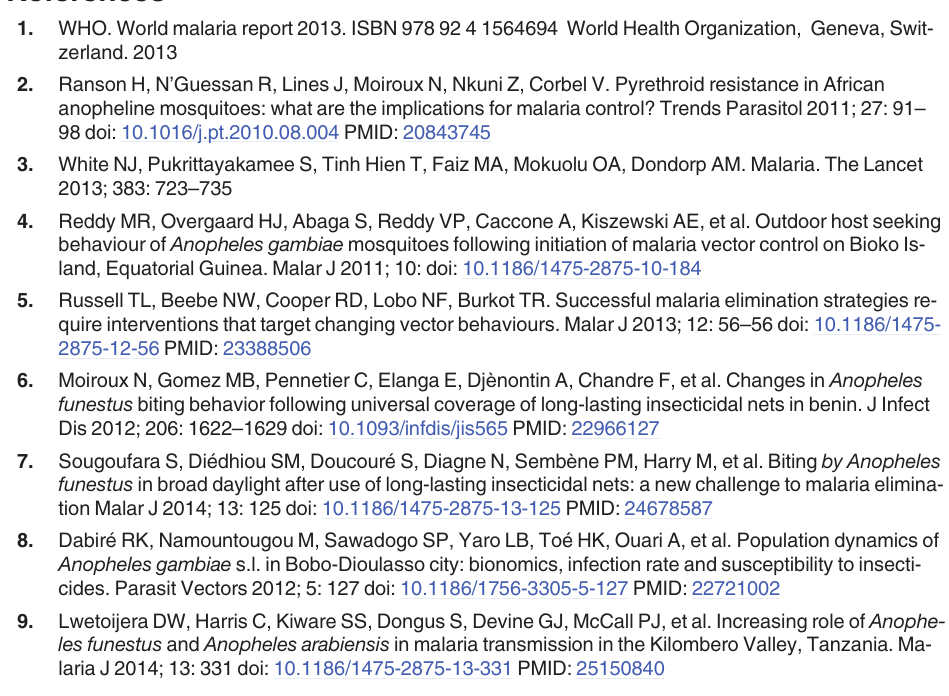
S2 Fig. Model simulations of a scenario in which mosquitoes are highly resistant against in- secticides. Shown is the entomological inoculation rate (EIR) as a function of different levels of pull efficacy. Pull efficacy is expressed as the relative attractiveness of the trap, compared to a human being. Push efficacy is expressed as the percentage of house entry reduction. S1 Table. Mean catches of Anopheles funestus mosquitoes for the different interventions. For the baseline data n = 8 (n = 7 for house 3) and for the intervention data n = 25. (DOCX) S2 Table. Mean catches of Anopheles gambiae s . l . mosquitoes for the different interven- tions. For the baseline data n = 8 (n = 7 for house 3) and for the intervention data n = 25.